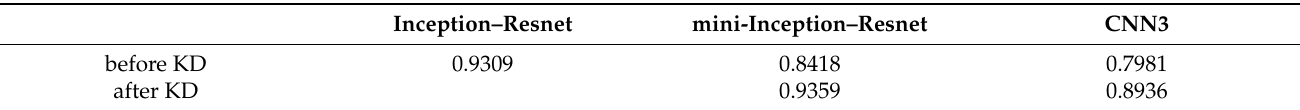
Table 1. Teacher network classification accuracy peak and comparison of student network classifica- tion accuracy peaks before and after knowledge distillation.